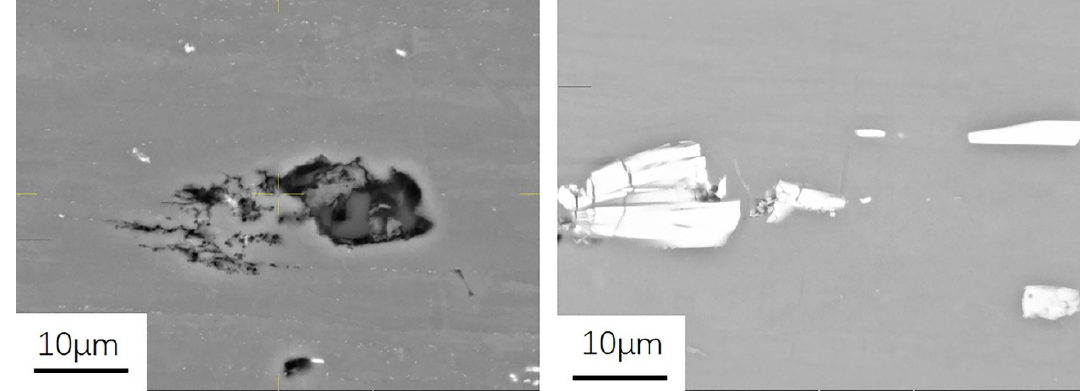
Figure 5. The morphology of undissolved second phases in 7B05 aluminum alloy.